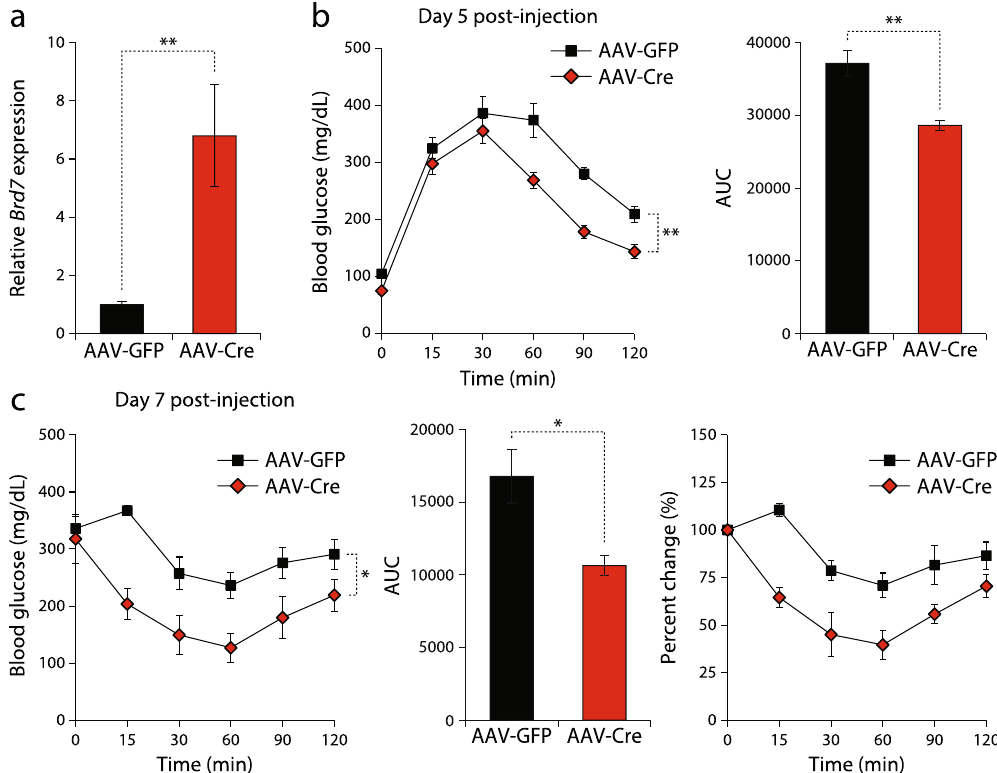
Figure 5. Upregulation of BRD7 in the liver at an early age improves glucose homeostasis. ( a ) Relative mRNA levels of Brd7 normalized to 18 s in the liver of HFD-fed male BRD7 Tg + / − mice injected with AAV-GFP or AAV-Cre at week 11 post-injection (n = 5/group). ( b ) Glucose tolerance test on day 5 post-injection (left). Area under curve (right). ( c ) Insulin tolerance test on day 7 post-injection (left). Area under curve (middle). Percent change of basal levels (right). Error bars are represented as mean ± SEM., P values were determined by Student’s t -test. ( * p < 0.05, ** p < 0.01, *** p < 0.001). Significance was determined by two-way analysis of variance (ANOVA) with Bonferroni multiple-comparison